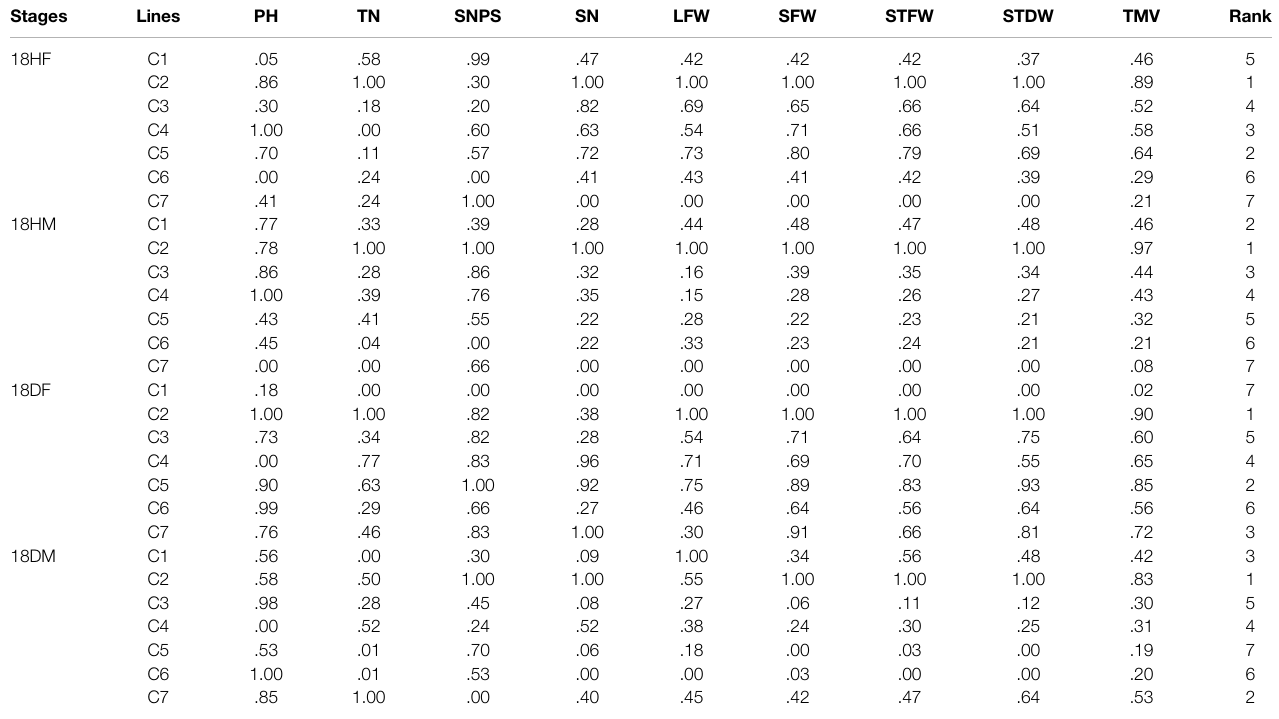
TABLE 1 | Membership function analyses of salt tolerance in seven Th. ponticum lines. Stages Lines